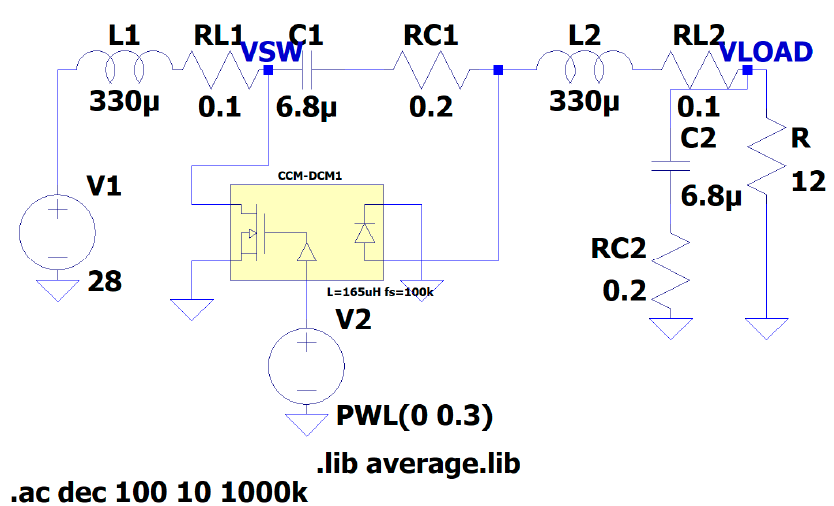
Figure 18. Circuit averaged model.